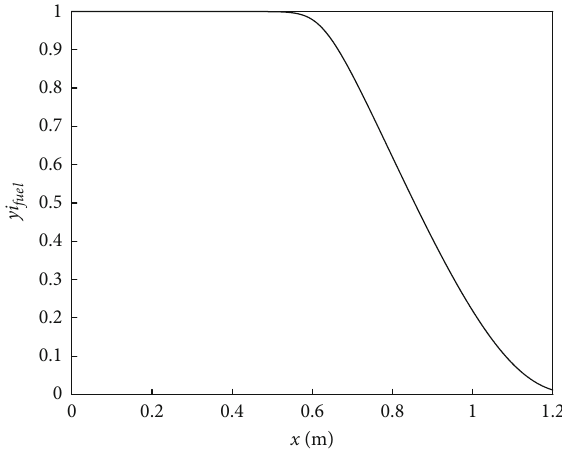
Figure 19: Distributions of fuel mass fraction along the cooling